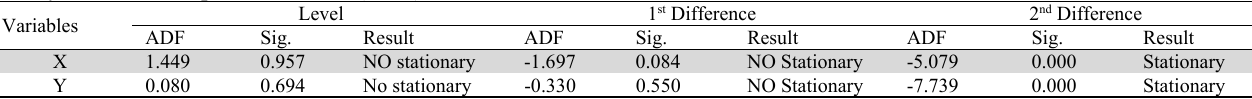
Dickey-Fuller developed test results (ADF) Variables